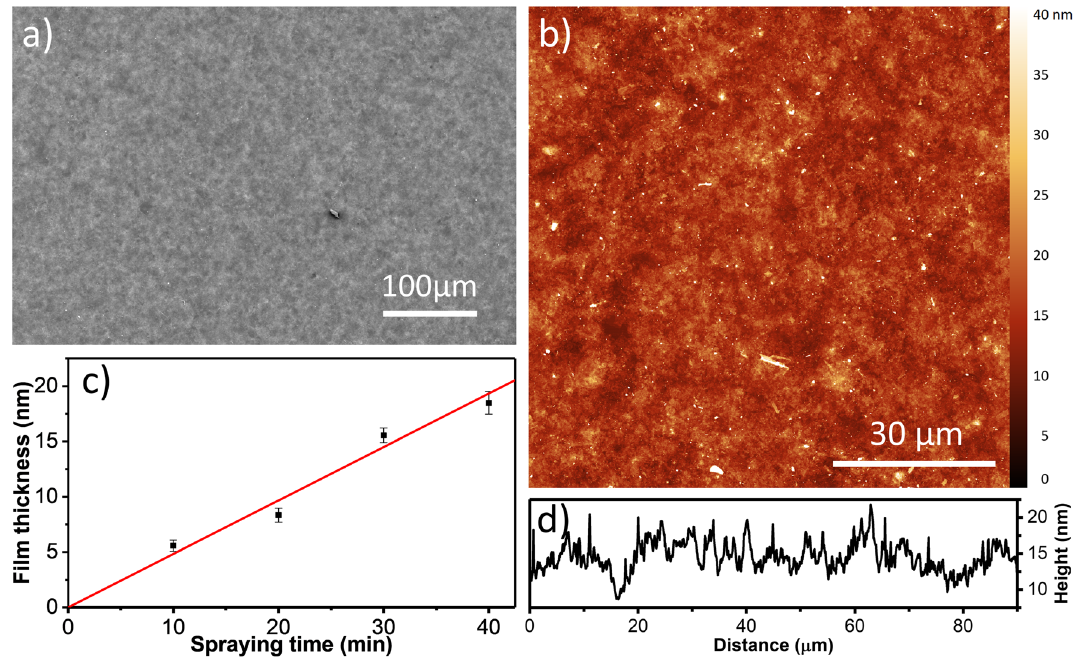
Figure 2. Electrosprayed nanosheets fully covering the substrate. ( a ) SEM image, ( b ) AFM image, ( c ) Film thickness versus spraying time, and the linear fit of the data points to determine the average deposition rate of the electrospraying process, ( d ) height line profile of film shown in ( c